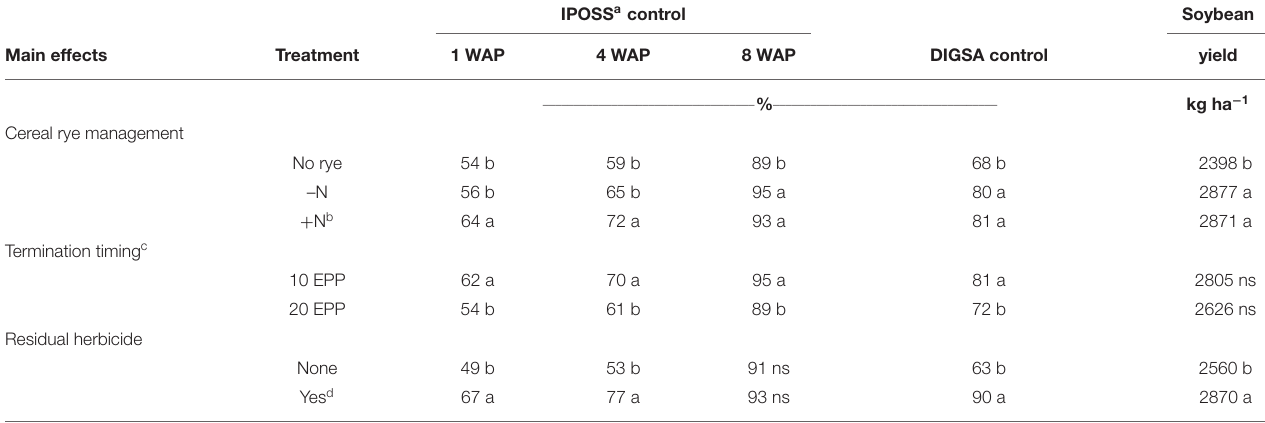
TABLE 5 | Influence of cereal rye management, termination timing, and residual herbicide on control of morningglory spp. and large crabgrass and soybean